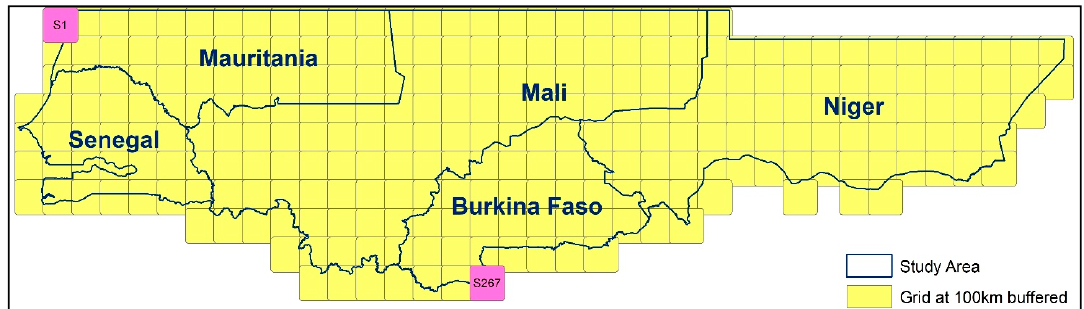
Figure 1. The grid of 100 × 100 km cells.